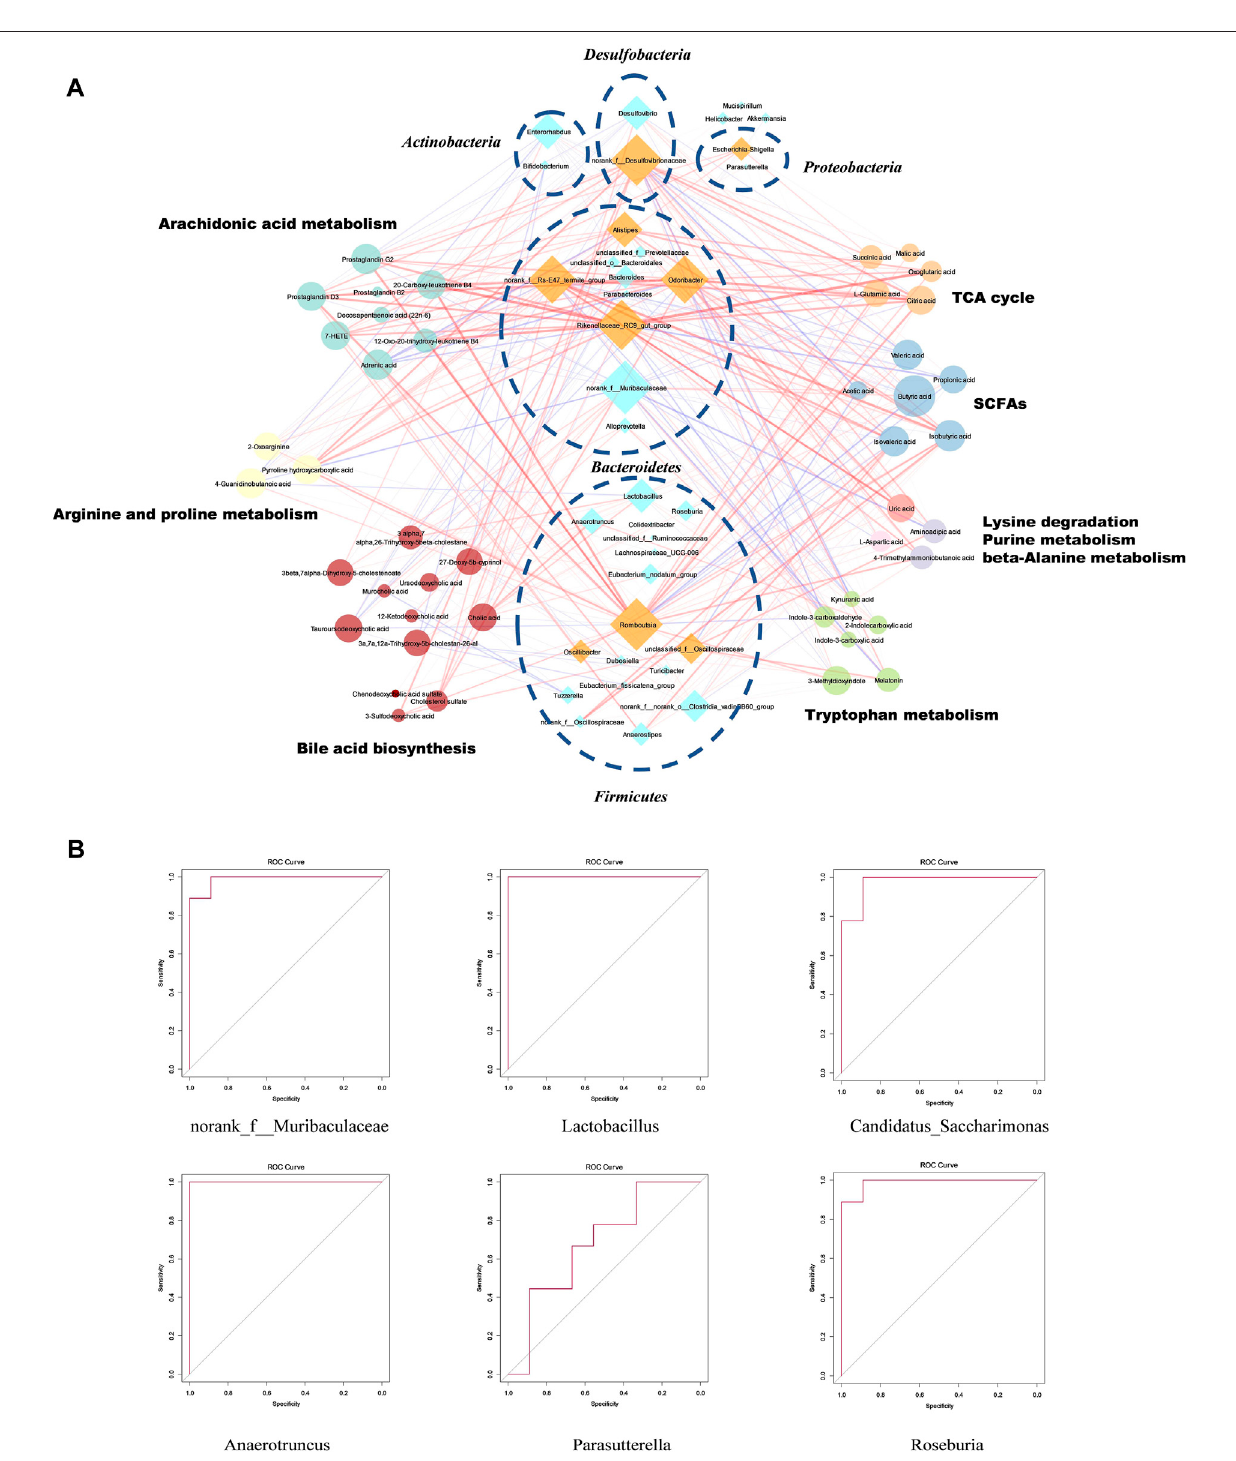
FIGURE 5 | The relationship between bacteria and metabolic pathways, and functional speci fi c bacteria in SFE treatment. (A) Co-expression network of speci fi c bacteria and differential metabolites (the strength of the interaction is represented by the thickness and depth of the lines. The stronger the interaction, the thicker and darker a line is. The red line represents the positive relationship, and the blue line represents the negative relationship, the main pathogenic bacteria of UC are shown as orange). (B) The ROC curve constructed based on six functional speci fi c bacteria.